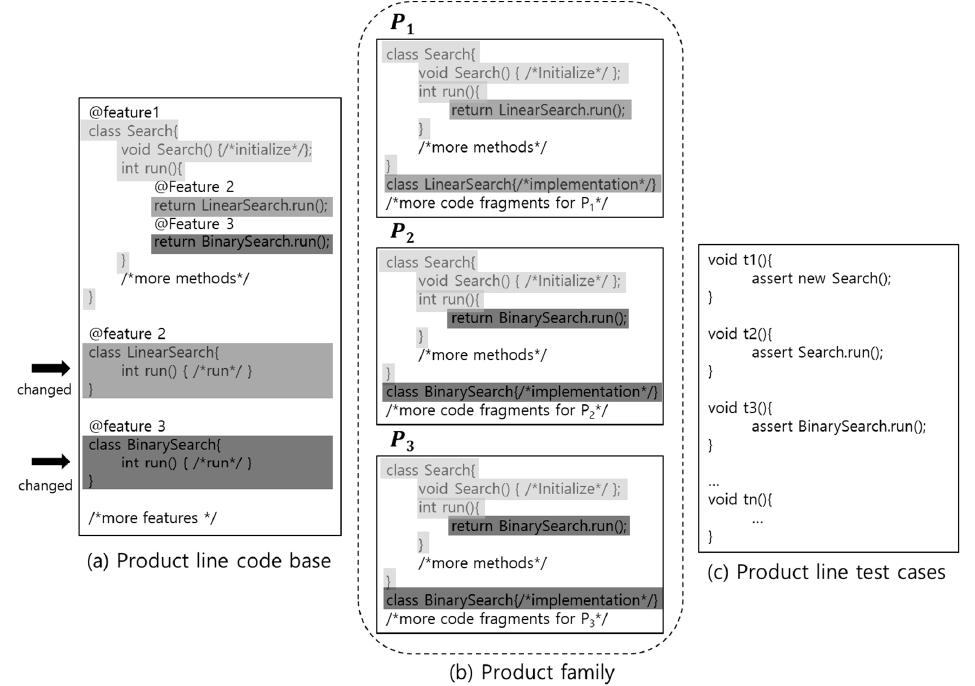
Figure 1. Examples of product line code base, product line test cases and product family.